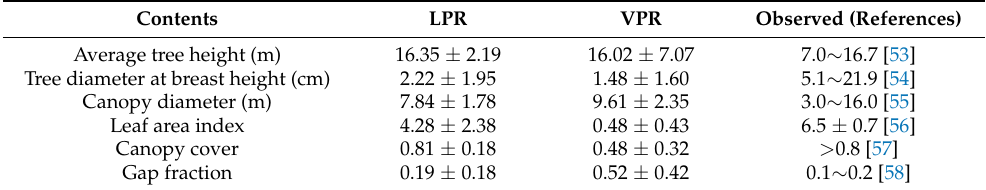
Table 3. Average values of the canopy